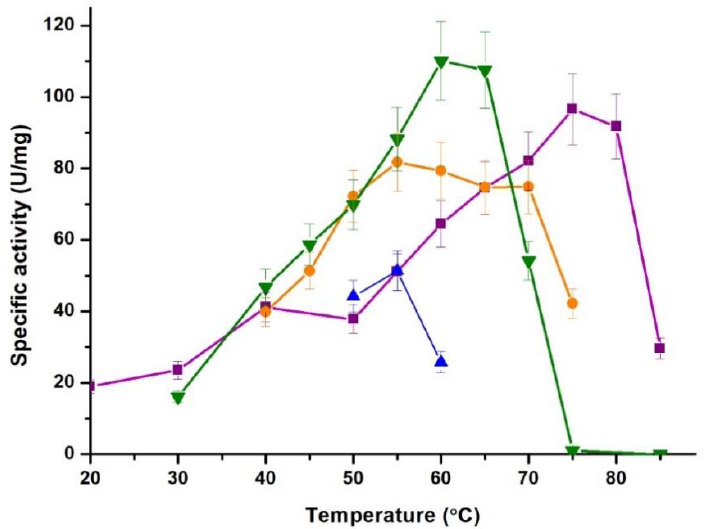
Figure 2. Temperature dependences of the specific activity of TaTT in the transamination reaction between L-Leu and α-ketoglutarate in 50 mM Na-phosphate buffer, pH 8.0, containing 50 mM NaCl (purple), and after the addition of 15% DMSO (orange), 15% methanol (olive) or 30% methanol (blue). All measurements were performed at least in triplicates. Error bars represent standard deviation. Table 1. Steady-state kinetic parameters of the transamination reaction catalyzed by TaTT at 50 °C.